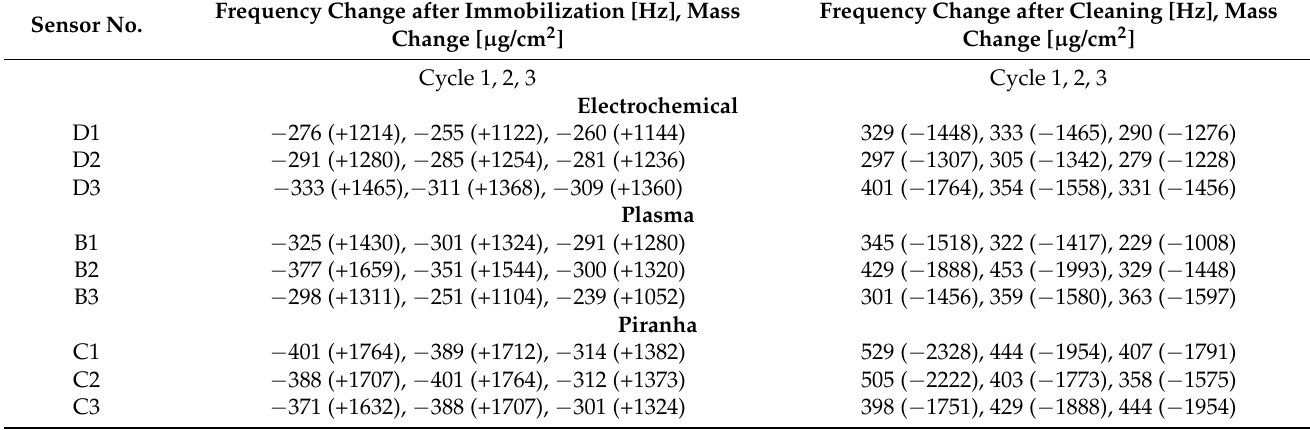
Table 2. Response of QCM transducers after OBPP4 peptide immobilization and after cleaning with selected